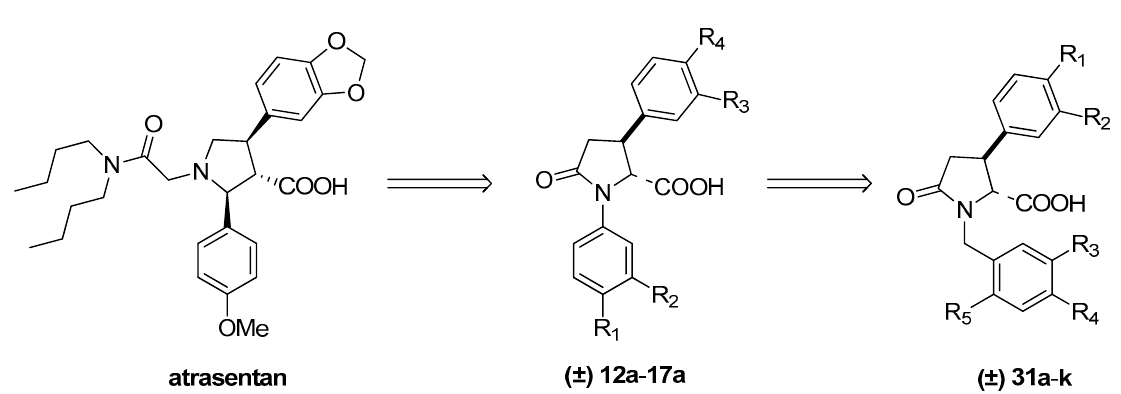
Figure 2. Chemical structures of atrasentan and the newly synthesized ligands.